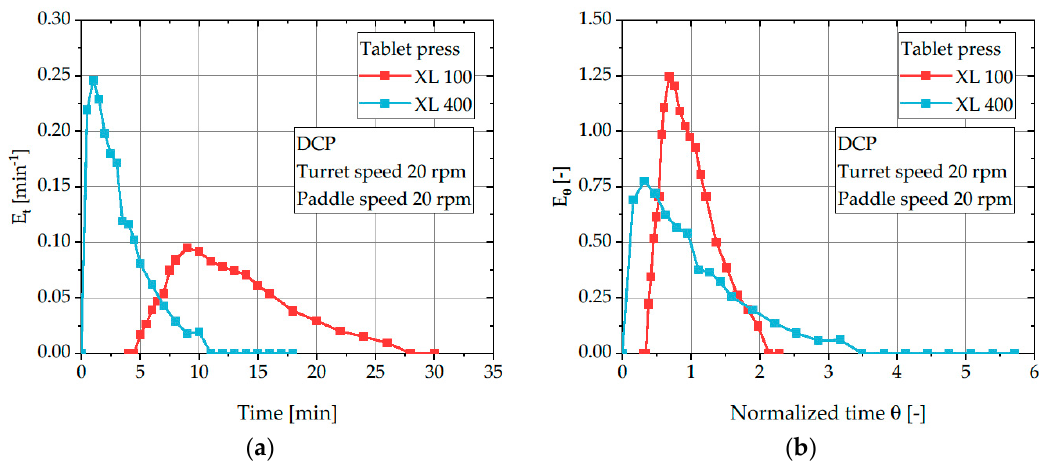
Figure 12. Residence time distribution E t ( a ) and normalized residence time distribution E θ ( b ) of DCP for turret and paddle speeds of 20 rpm on different tablet presses.